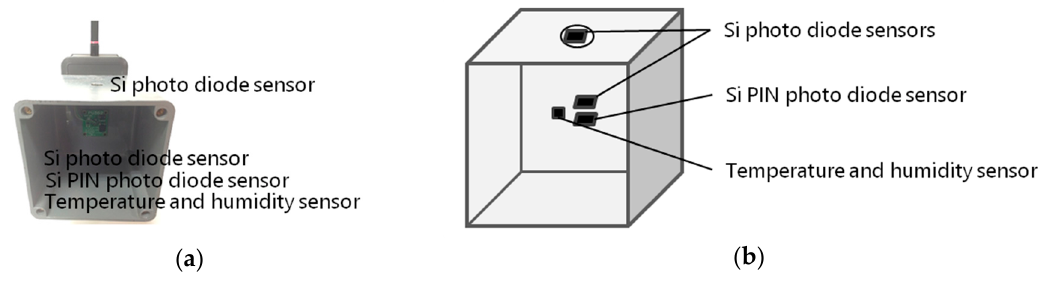
Figure 3. Scattered light sensor node. ( a ) photograph; ( b ) overview.